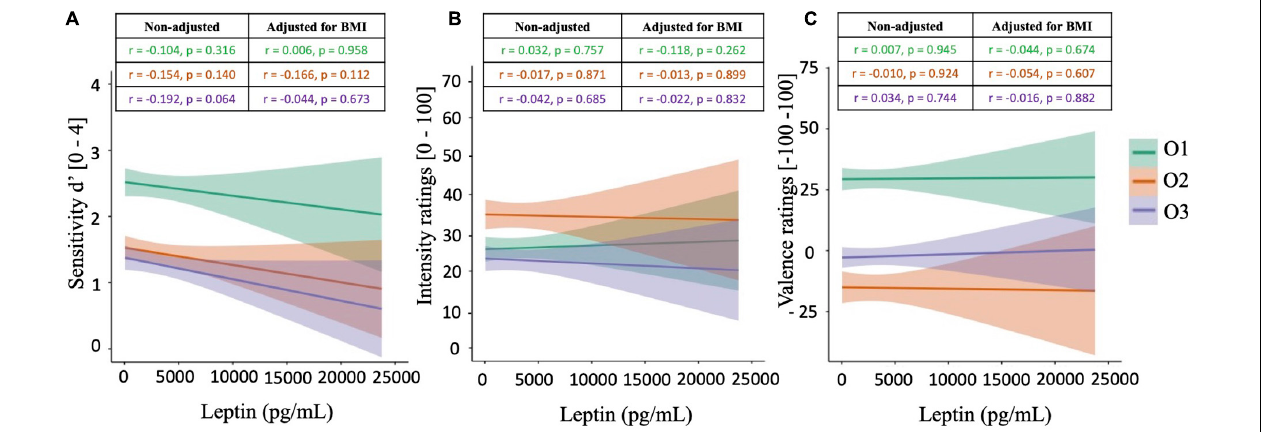
FIGURE 4 | Correlation plots between peripheral leptin levels and olfactory supra-threshold sensitivity (A) , olfactory intensity ratings (B) , and olfactory valence ratings (C) of the odorants O1 (vanilla odour ), O2 (potato odour ), and O3 (dairy odour ). All graphical plots illustrate results obtained from Pearson’s correlations (non-adjusted). Significant results are represented by ∗